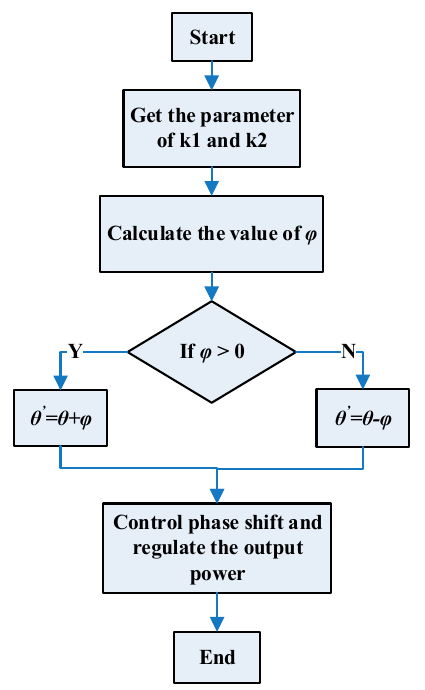
Figure 5. Flow chart of power regulation by phase-shift.